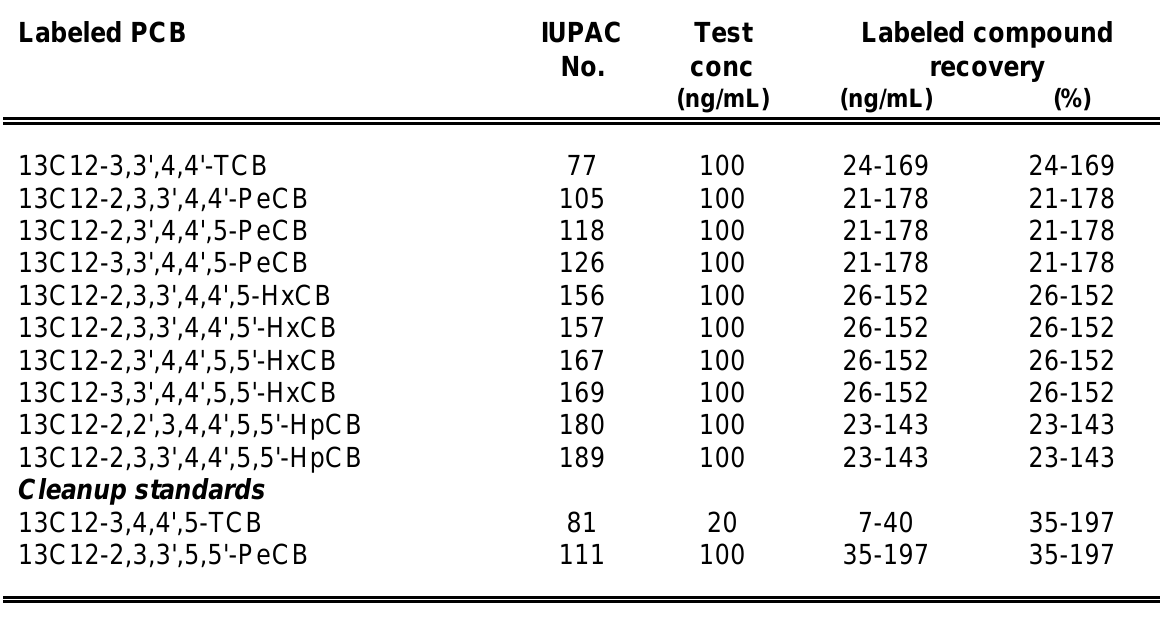
Table 7a. Labeled Compound Recovery When PCBs 77, 126, and 169 Only are Tested 1 Labeled PCB